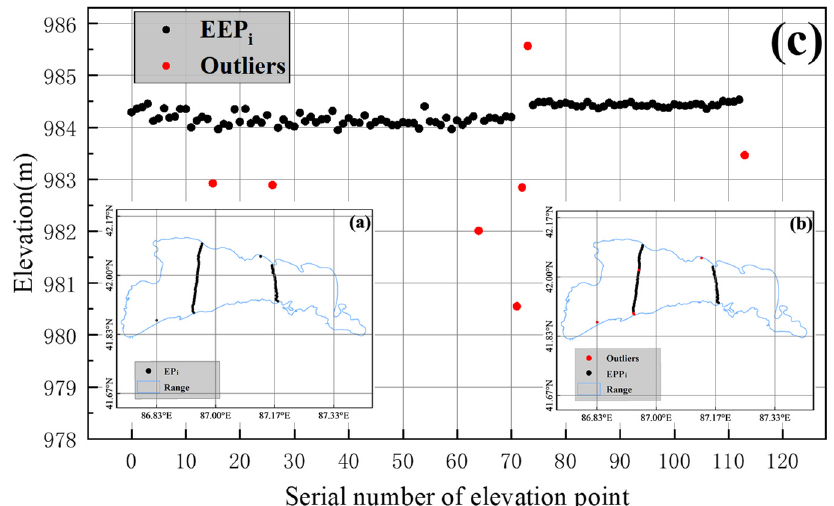
Figure 2. June 2015 data as an example. ( a ) Horizontal distribution of original footprints EP i in Bosten Lake. ( b ) Horizontal distribution of effective footprints EPP i and anomalous footprints outliers. ( c ) Vertical distribution of valid footprints EPP i and anomalous footprints outliers.